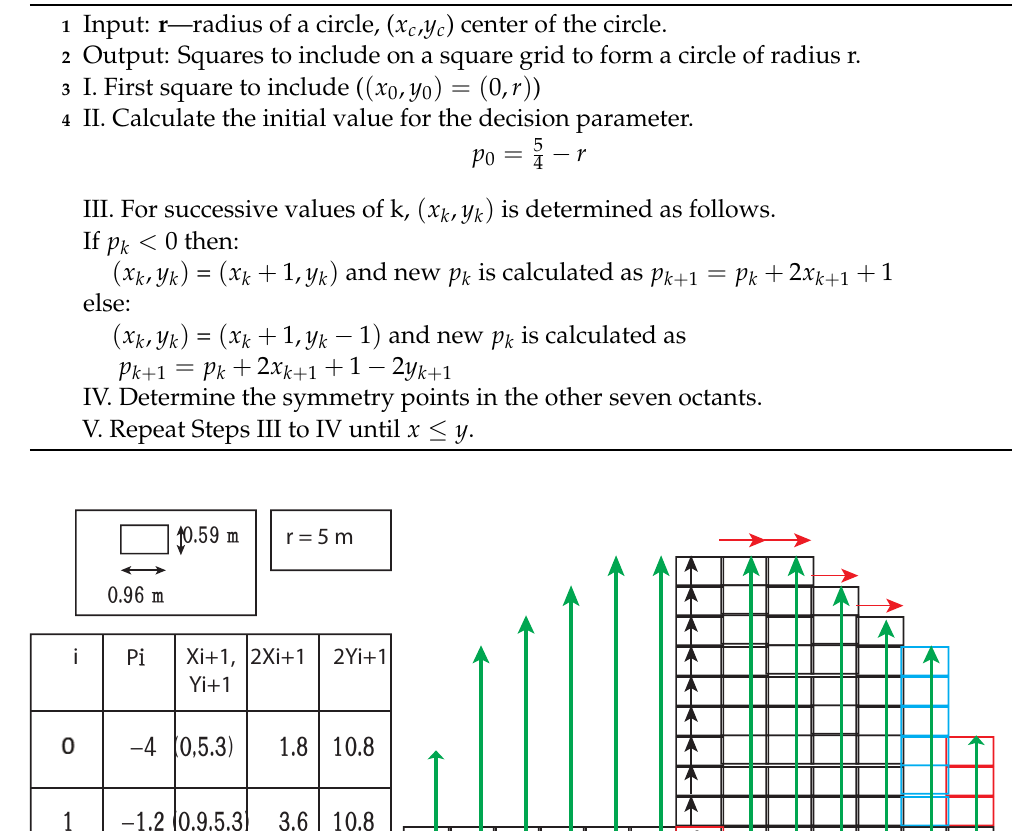
Algorithm 3: Midpoint circle generation algorithm.